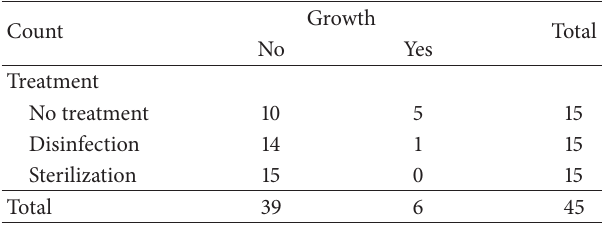
Table 1: Contingency table treatment ∗